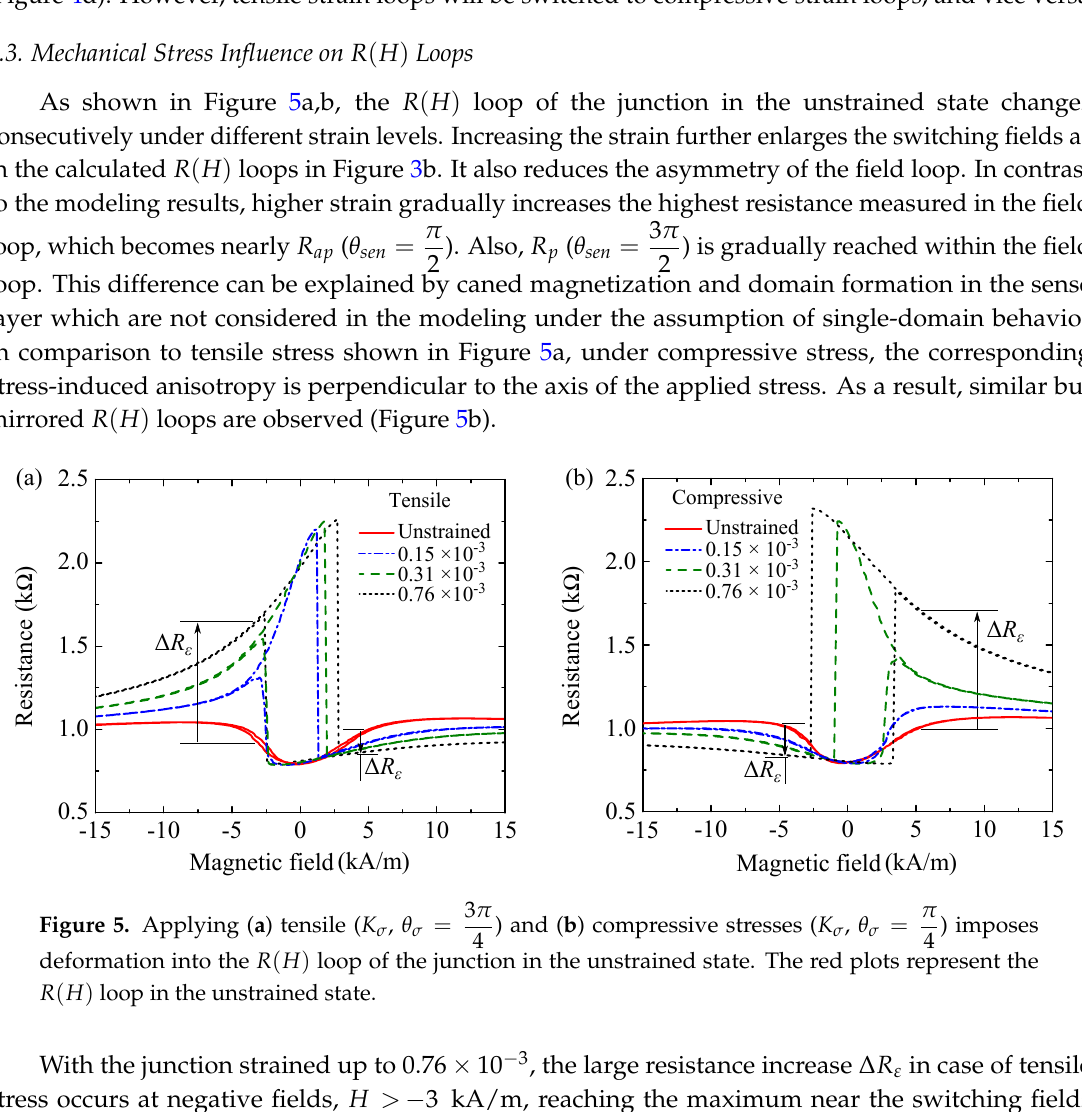
3 π ) and ( b ) compressive stresses ( K σ , θ σ = 4